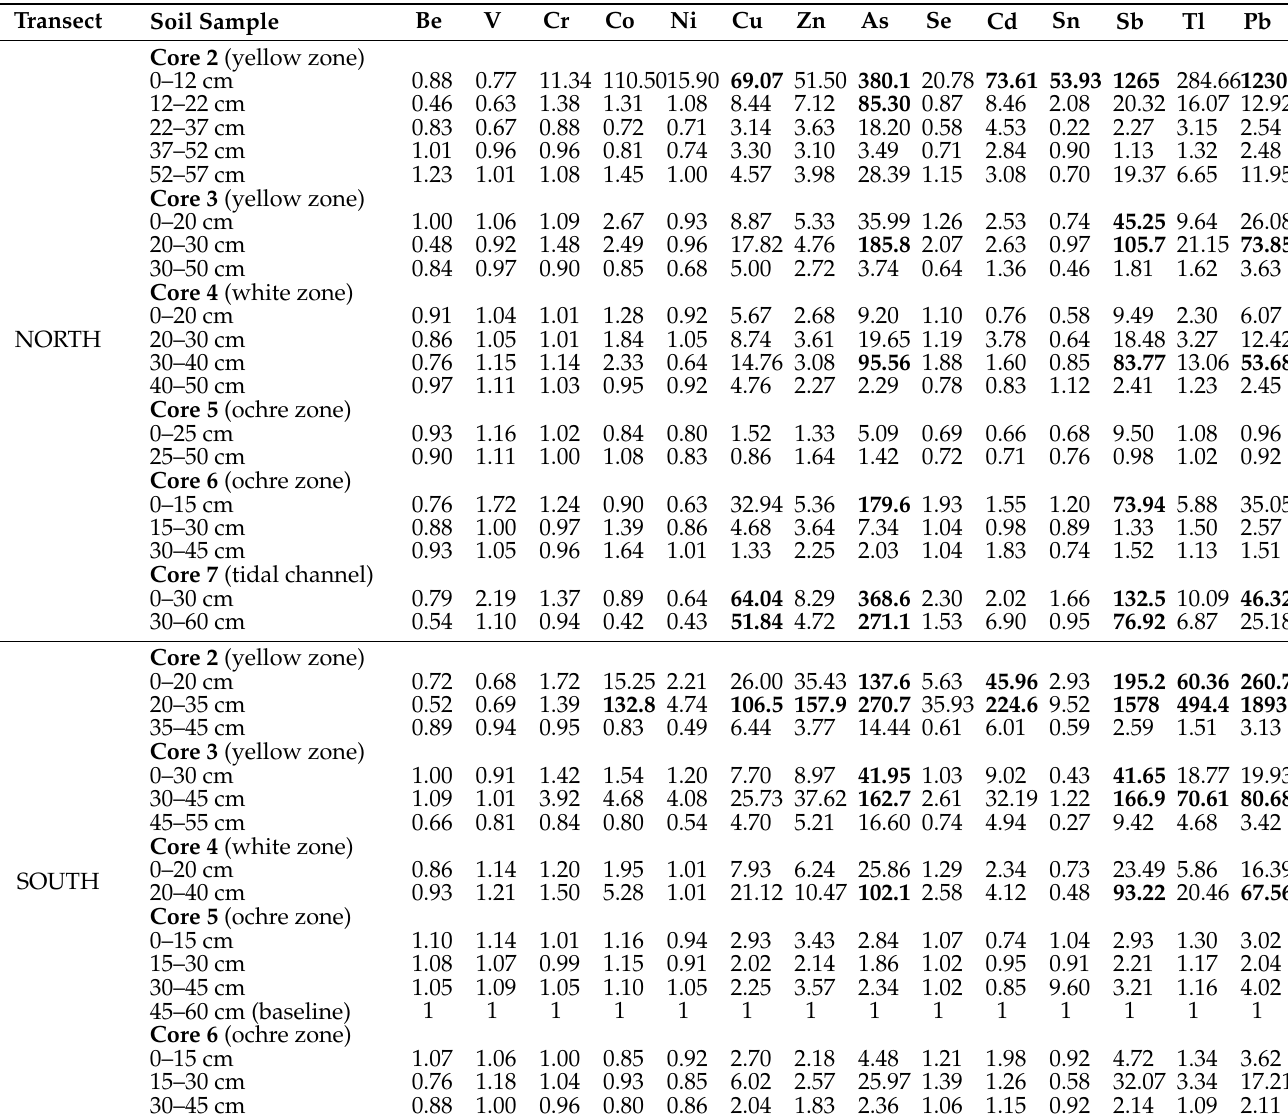
Table 4. Zr-normalized enrichment factor values for trace elements in the core soil samples. Values above 40 (in bold) are indicative of extremely high